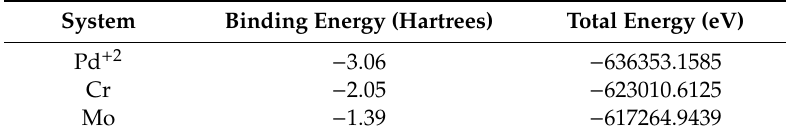
Table 1. BindingenergiesandtotalenergiesofthenanoballsusingE Pd + 2 = − 3425.461eV,E Cr = − 2315.861 eV, E Mo = − 1838.547 eV, and E ligand = − 24,798.535